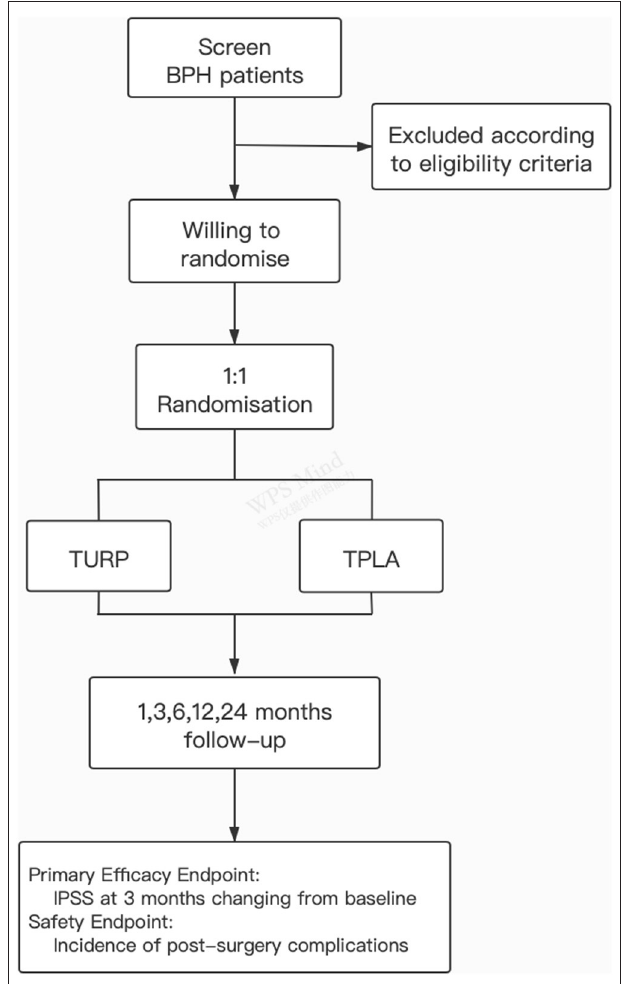
FIGURE 1 | Subject diagram. The flow diagram of this randomised controlled